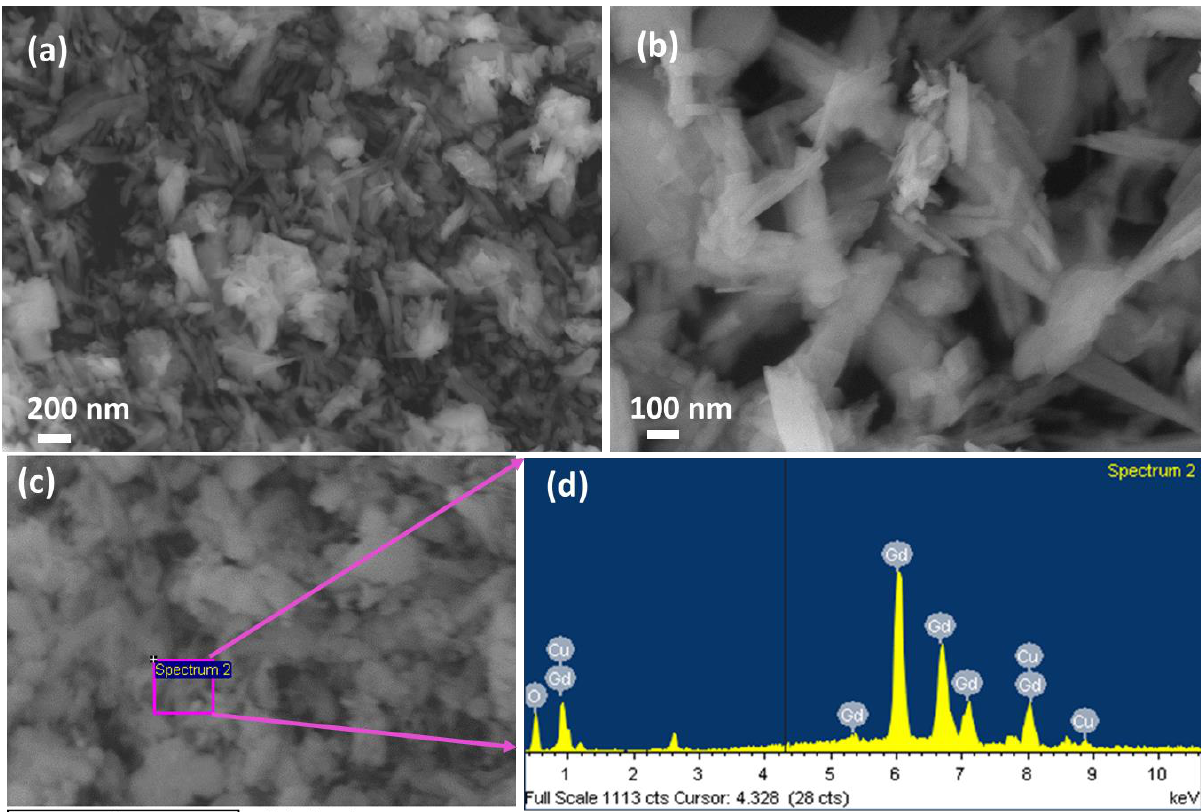
Figure 2. Morphological and elemental analysis. ( a , b ) Low to high-resolution FE-SEM images and ( c , d ) EDS spectrum of the CGO nanofibers.